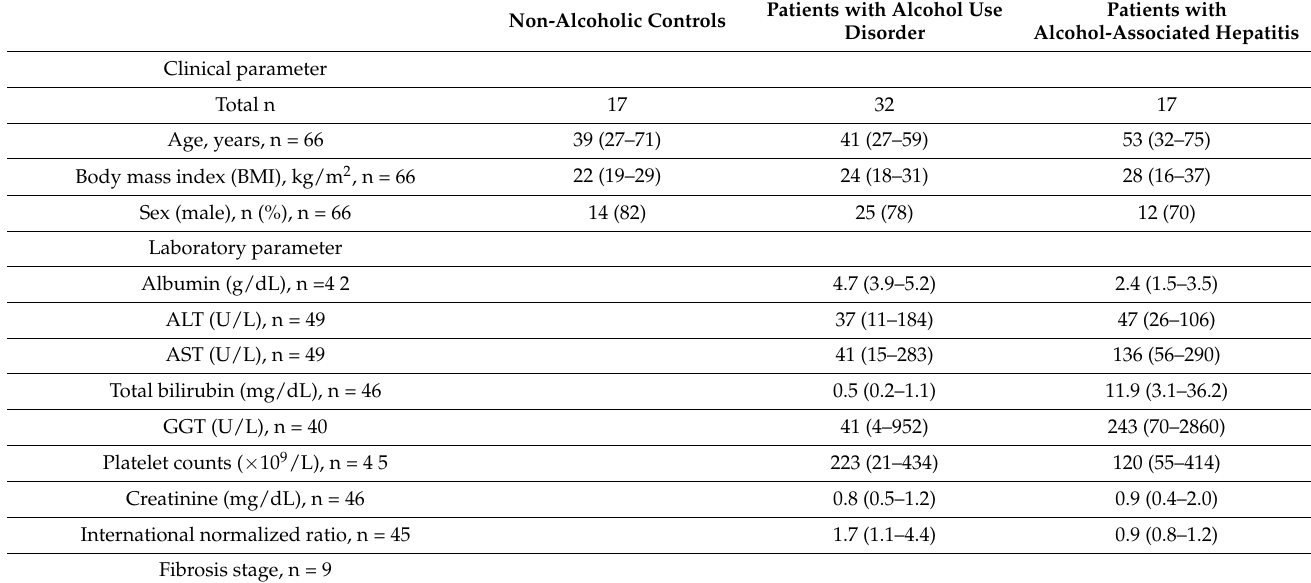
Table 1. Subject